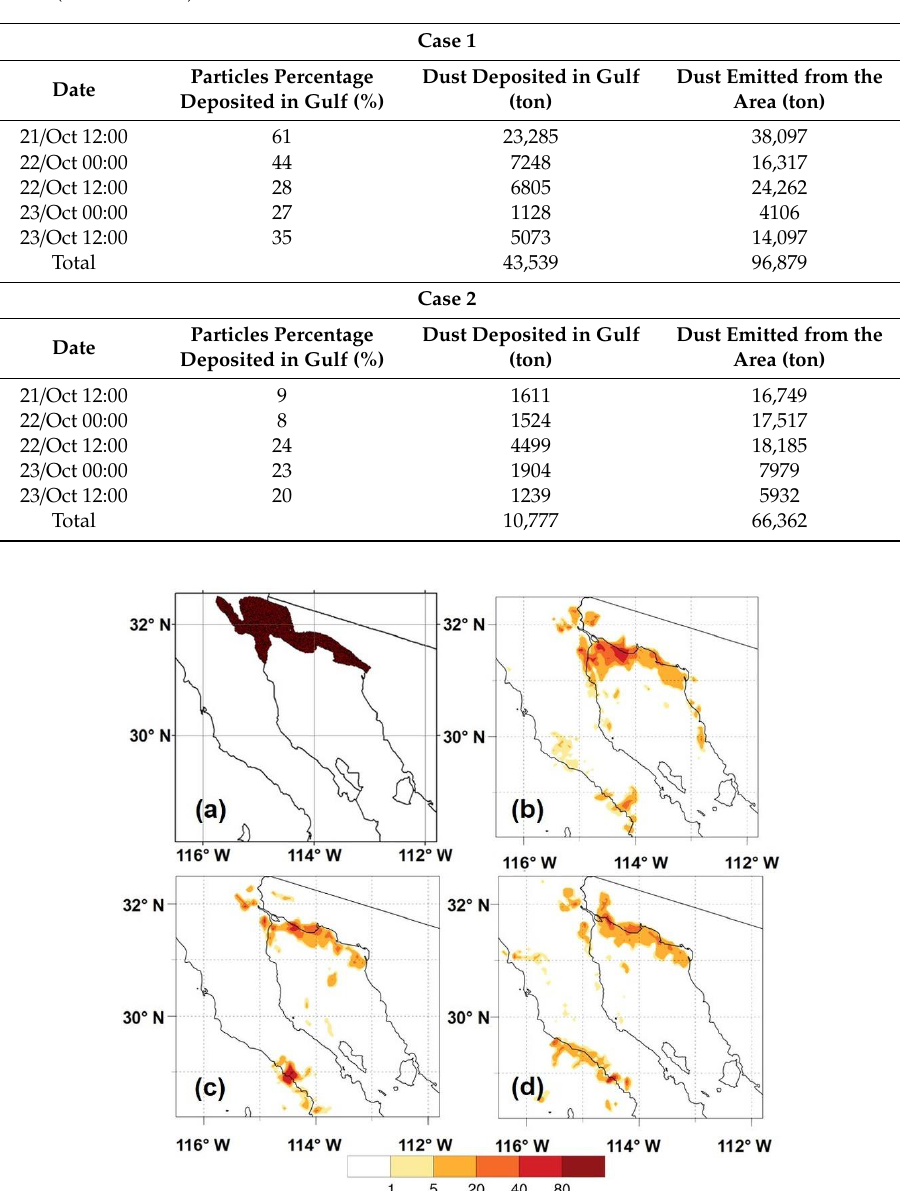
Table 3. Results of estimation of dust deposition in the Gulf emitted by the areas of case 1 (Altar Desert) and case 2 (Sonora coast).